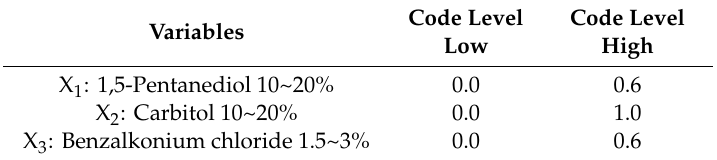
Table 2. Variables and intervals selected to perform the constrained mixture